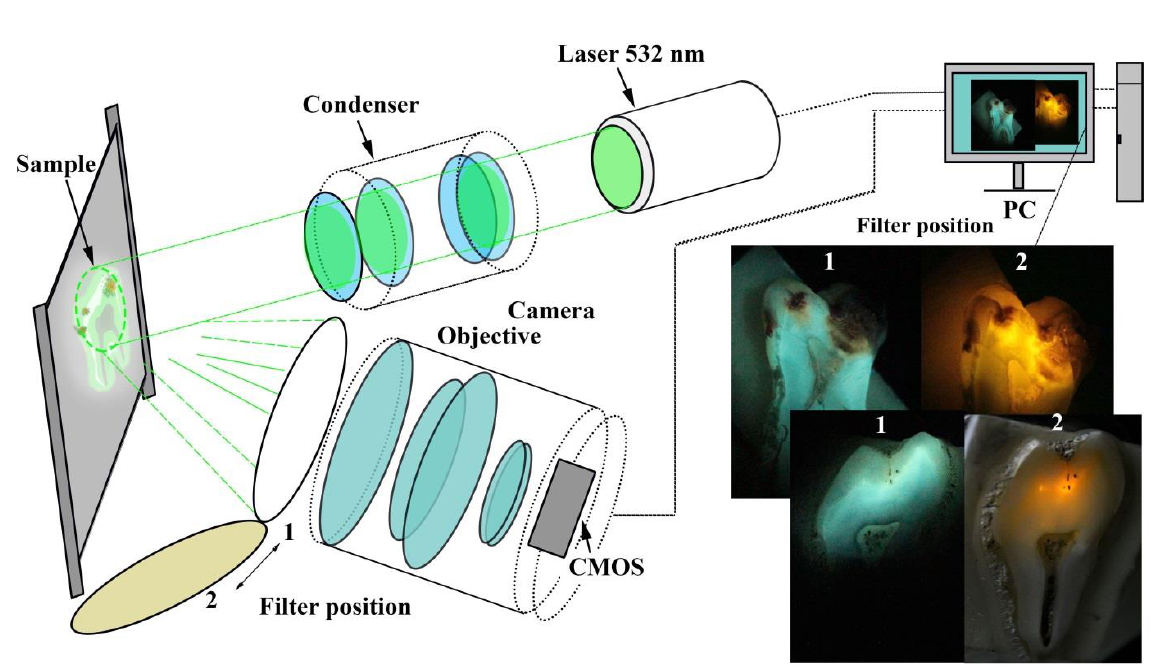
Figure 2. Schematic image of the apparatus for observing laser-induced